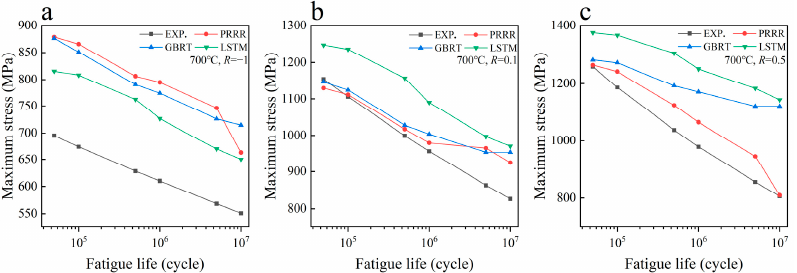
Figure 5. Predicted results of different machine learning models for the fatigue strength of the nickel ‐ based superalloy in case 2: ( a ) 700 °C, R = − 1; ( b ) 700 °C, R = 0.1; ( c ) 700 °C, R = 0.5.